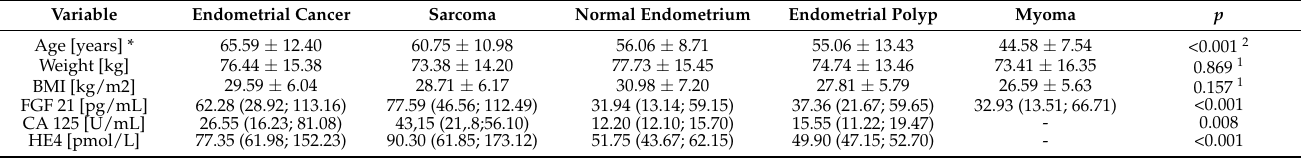
Table 2. Comparison of the selected variables between the study